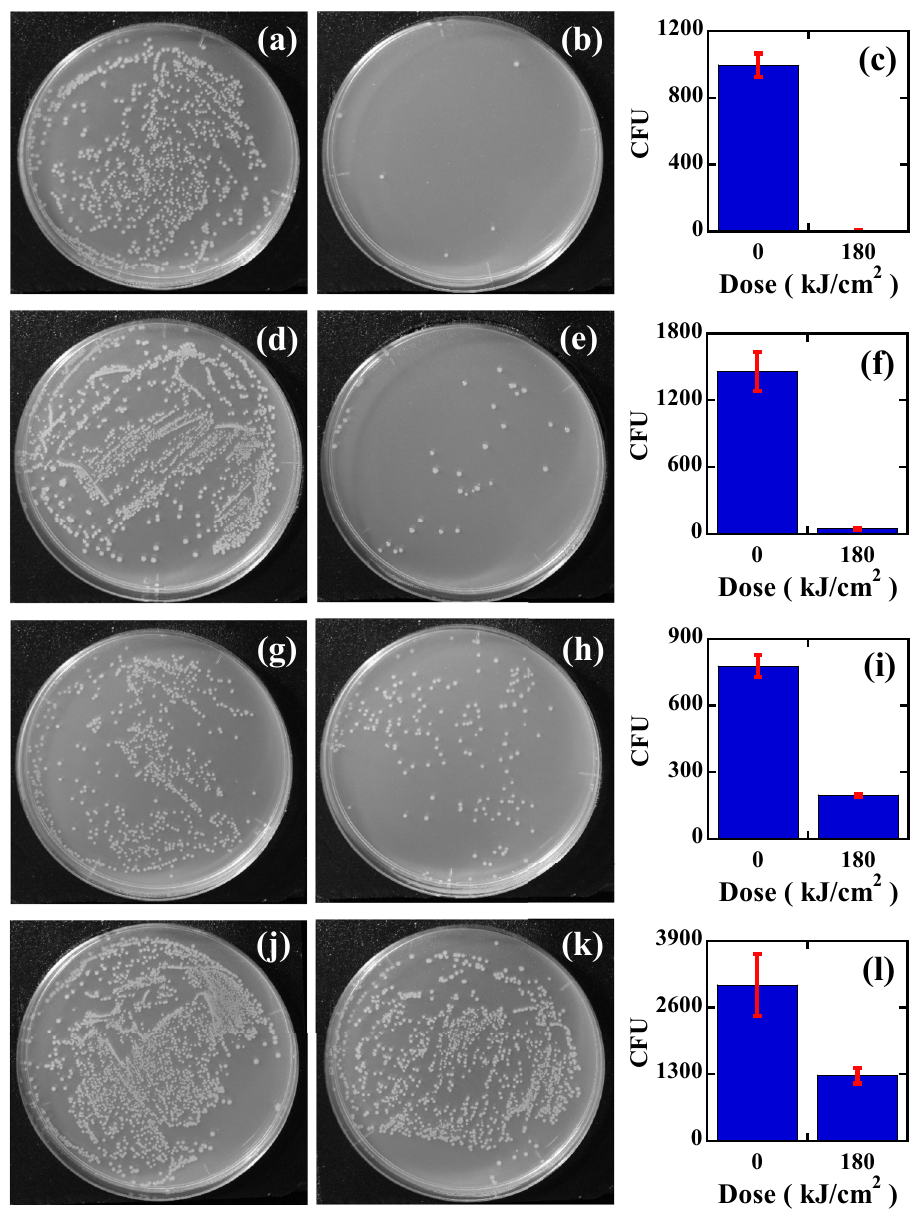
Figure 4. The results of the efficacy of inactivation for crystal violet-stained E. coli O1 by using the tunable pulsed laser. ( a ) Control plate of a 420 nm pulsed laser, ( b ) plate inactivated by a 420 nm pulsed laser, and ( c ) the number of CFU on the control plate (995 ± 70 CFU) and treated plate (4.3 ± 0.9 CFU) with a 420 nm pulsed laser. ( d ) Control plate of a 500 nm laser, ( e ) inactivated plate by a 500 nm laser, and ( f ) the number of CFU on the control plate (1457 ± 175 CFU) and treated plate (48 ± 8.5 CFU) with a 500 nm pulsed laser. ( g ) Control plate of a 600 nm laser, ( h ) plate inactivated by a 600 nm laser, and ( i ) the number of CFU on the control plate (776 ± 50.0 CFU) and treated plate (197 ± 6.0 CFU) with a 600 nm pulsed laser. ( j ) Control plate of a 650 nm laser, ( k ) plate inactivated by a 650 nm laser, and ( l ) the number of CFU on the control plate (3034 ± 601 CFU) and plate (1276 ± 158 CFU) treated with a 650 nm pulsed